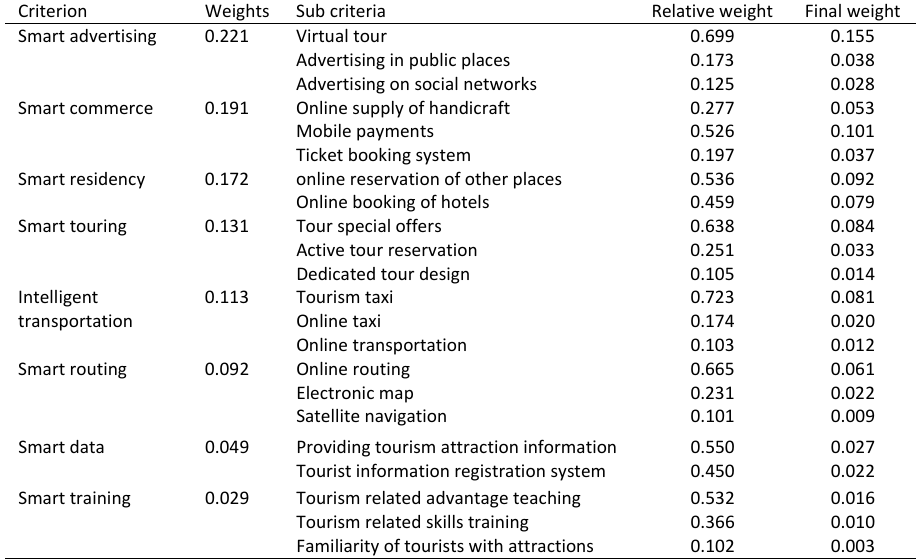
Table 1: Final weights of sub criteria Table 1. Final weights of sub